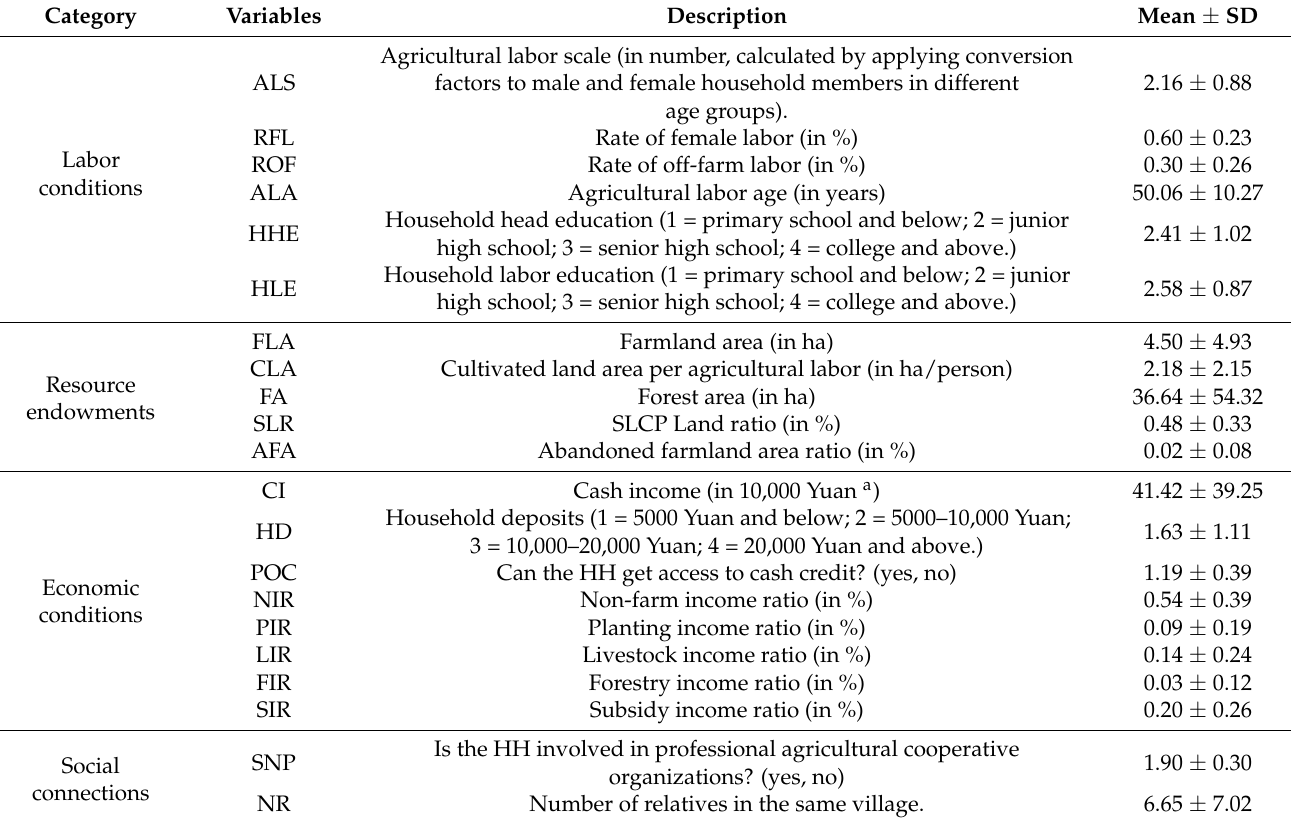
Table 1. Variables delineating household